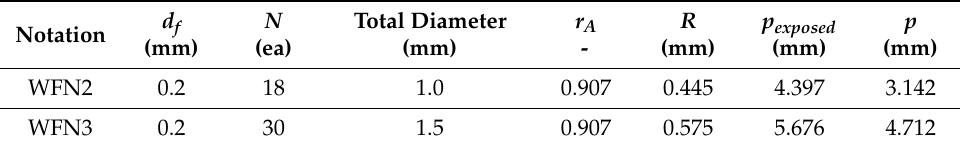
Table 4. Theoretical consideration of multifilament WFN